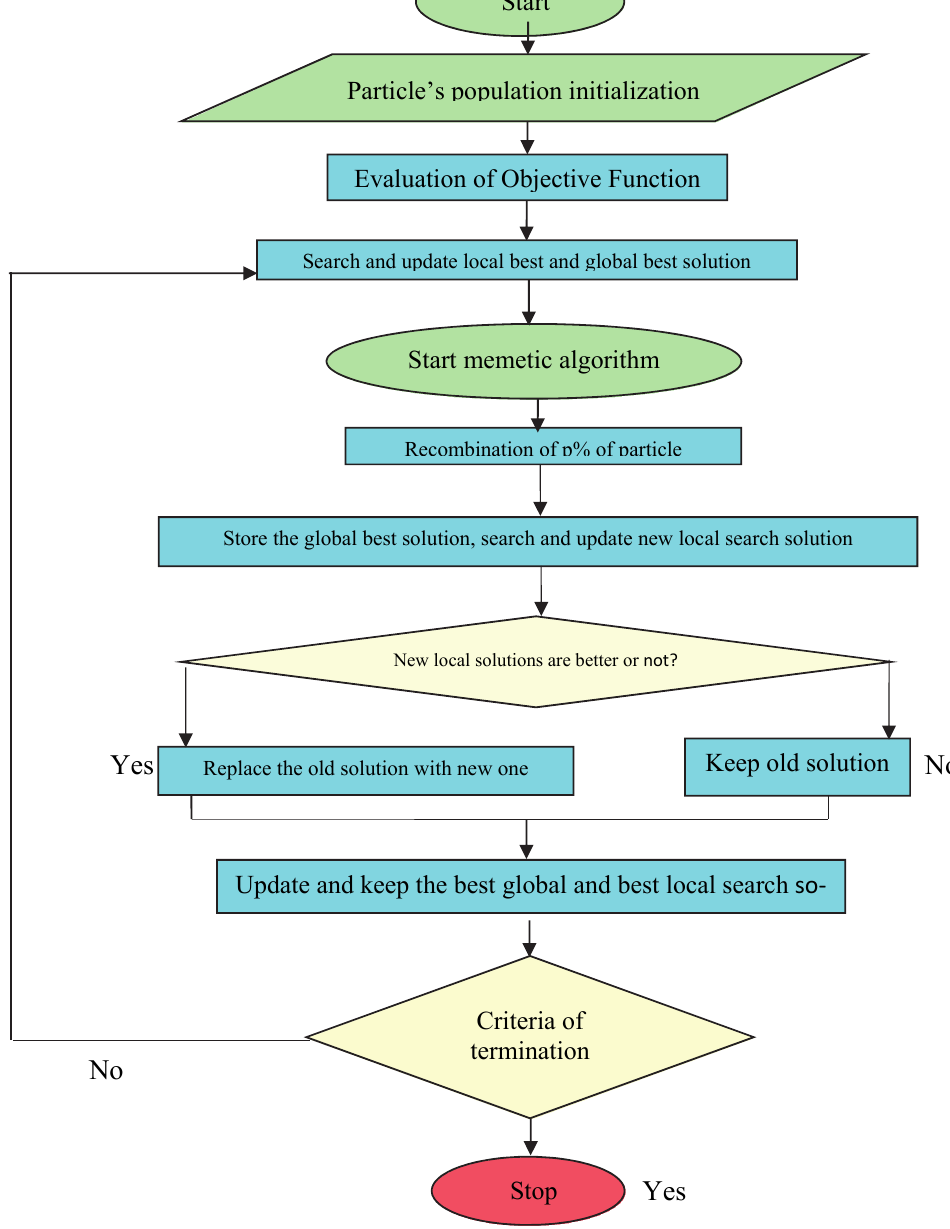
Fig. 1. The Modified Memetic Particle Swarm Optimization Process Flowchart.